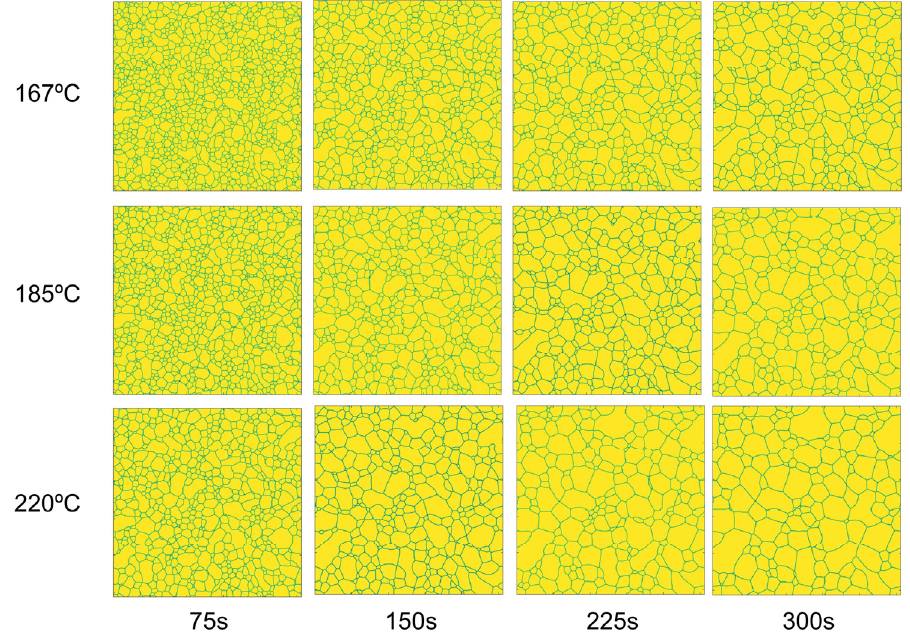
Figure 1. Simulated grain structures of zone-refined tin after 75, 150, 225, and 300 s (columns 1–4) during the isothermal process at a temperature of 167 °C, 185 °C, and 220 °C.